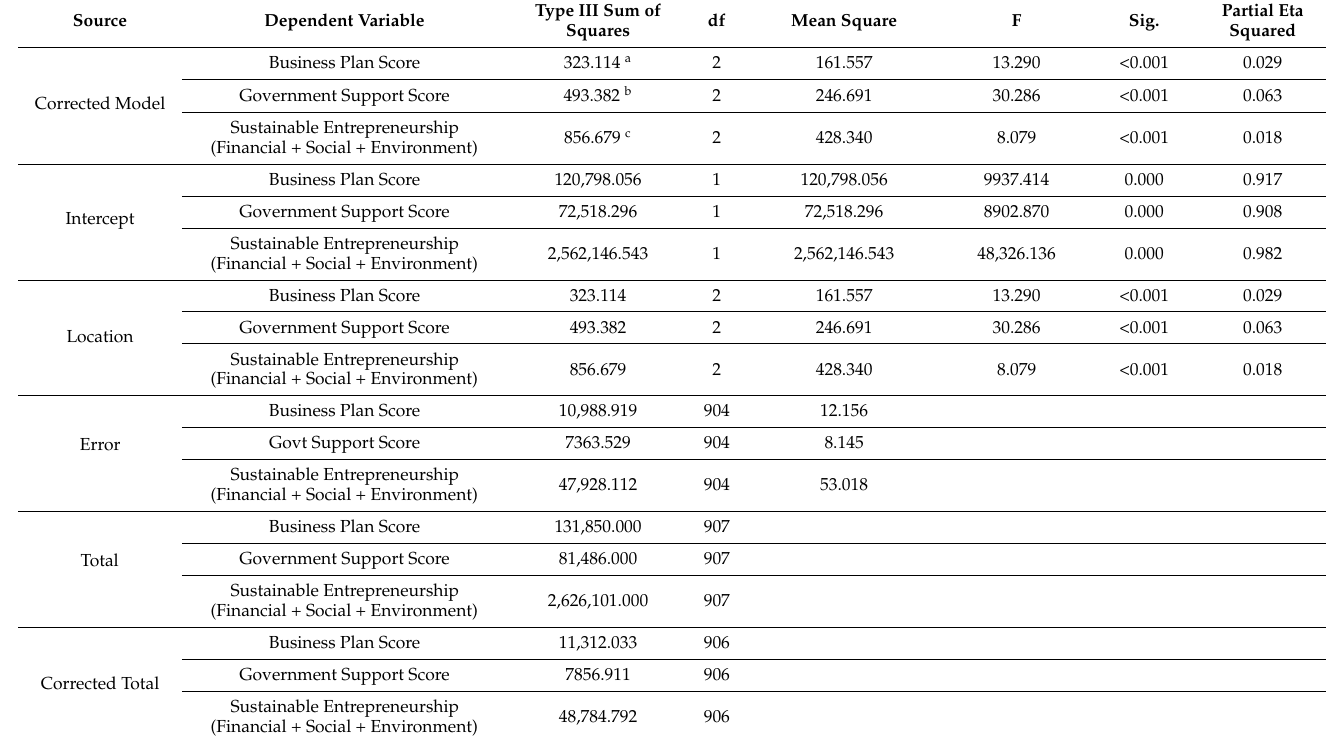
Table 10. Tests of between-subject